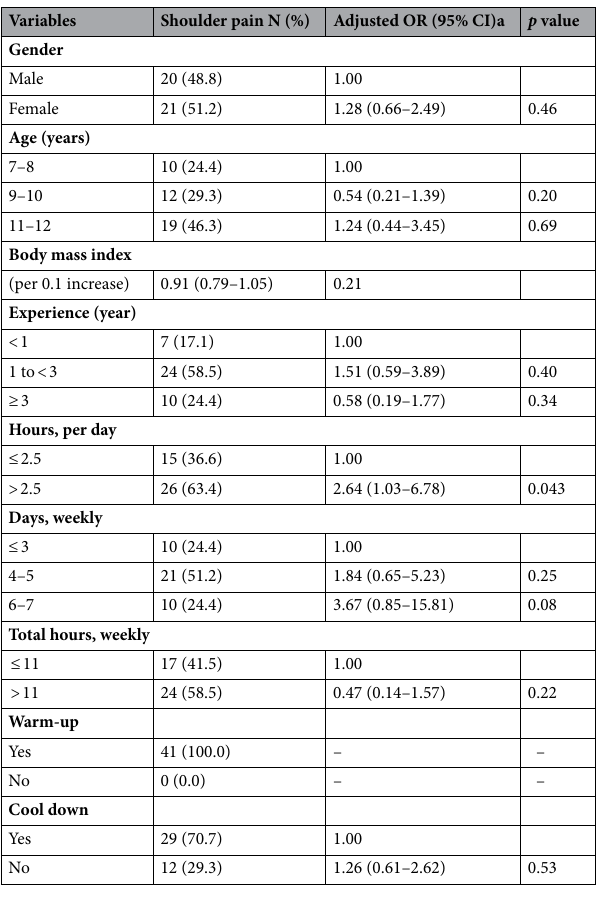
Table 4. Adjusted odds ratio for shoulder pain by multivariate analysis. OR odds ratio, CI confidence intervals. *Significantly associated with shoulder pain, P-value < 0.05. a Adjusted for gender (male or